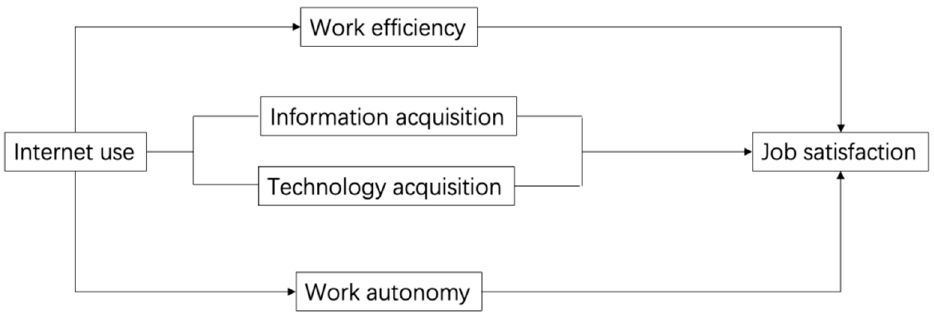
Figure 1. Logical Framework Diagram.